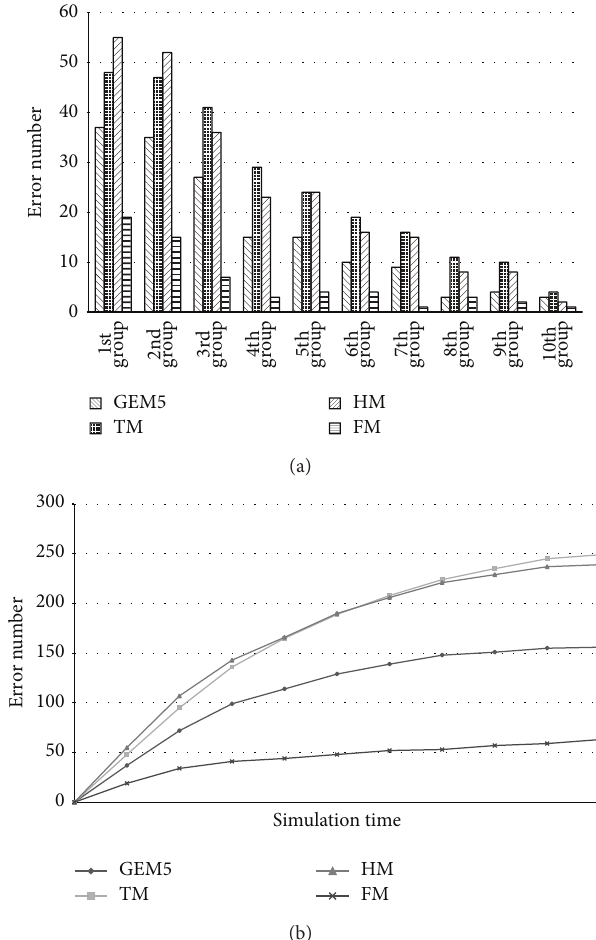
Figure 11: (a) Error number found by test groups; (b) accumulated errors.